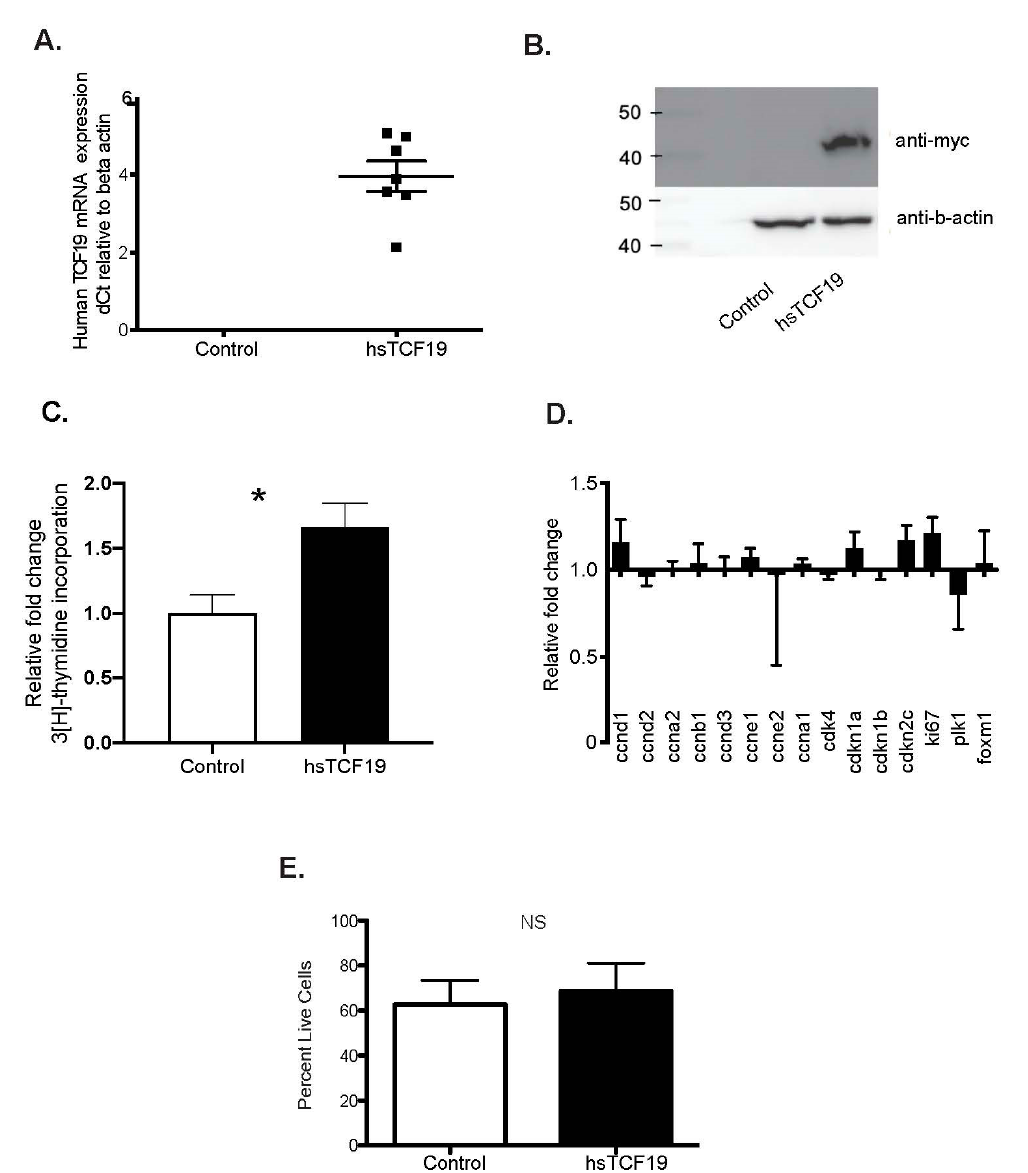
Figure 1. ( A ) Overexpression of human transcription factor 19 (TCF19) in INS-1 cells was confirmed by qRT-PCR. ( B ) Western blot against anti-myc tag confirms overexpression of human TCF19 (hsTCF19) ( C ) Overexpression of hsTCF19 in INS-1 cells leads to increased 3 H-thymidine incorporation (n = 5). ( D ) hsTCF19 overexpression does not lead to any significant changes in cell cycle gene expression (n = 5) ( E ) Overexpression of hsTCF19 in INS-1 cells does not affect cell viability (n = 5). Data are means ± SEM * p <